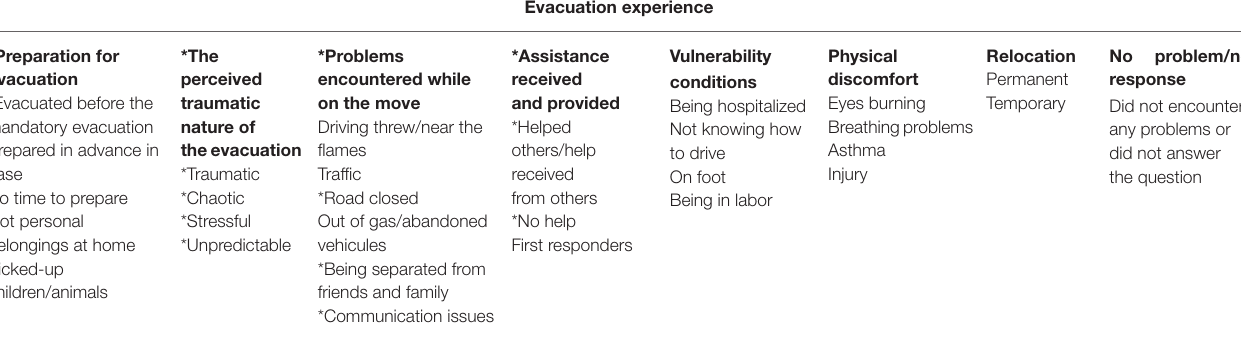
TABLE 2 | Evacuation